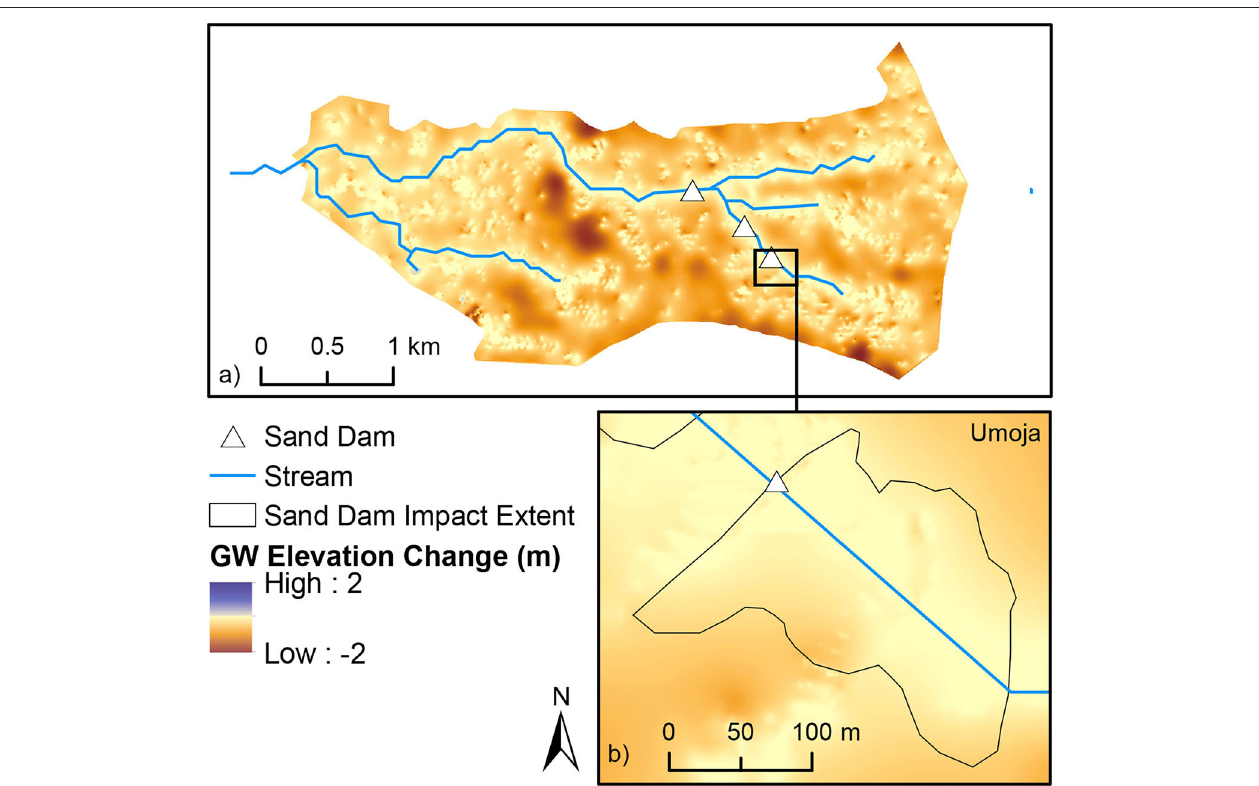
FIGURE 10 | The difference between S1 and S4 groundwater (GW) elevation change at the end of the simulation period for (a) the Chididimo watershed and (b) the Umoja sand dam. A positive value indicates S1 produced a more desirable change in GW elevation relative to S4.